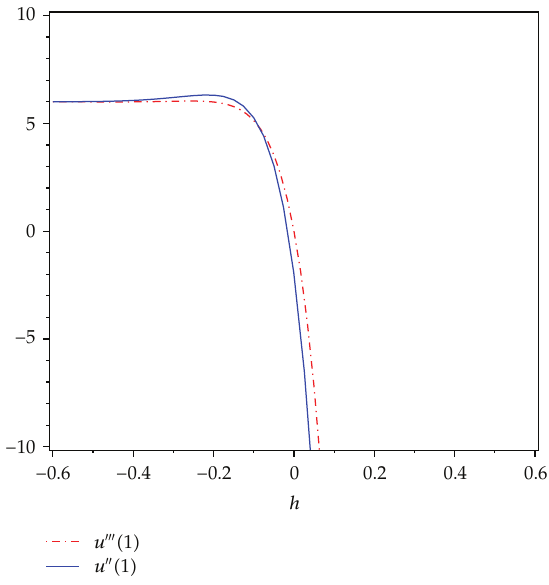
Figure 6: 23th-order HAM h -curve. Table 4: Absolute errors for Example